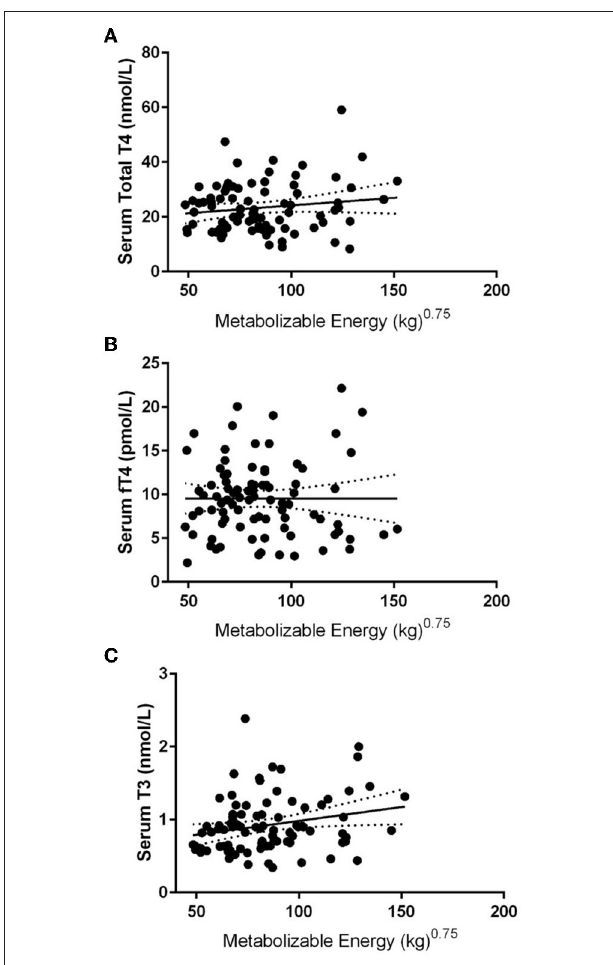
FIGURE 2 | Pearson linear regression statistics comparing various thyroid hormone concentrations vs. metabolizable energy intake in 86 Alaskan Sled Dogs. (A) Linear regression with 95% confidence intervals of TT4 to metabolizable energy showing weak insignificant correlation ( R = 0.14). (B) Linear regression analysis with 95% confidence intervals of fT4 to metabolizable energy showing weak insignificant correlation ( R = 0.01). (C) Linear regression analysis with 95% confidence intervals of T3 to metabolizable energy showing weak significant correlation ( R = 0.23: p =